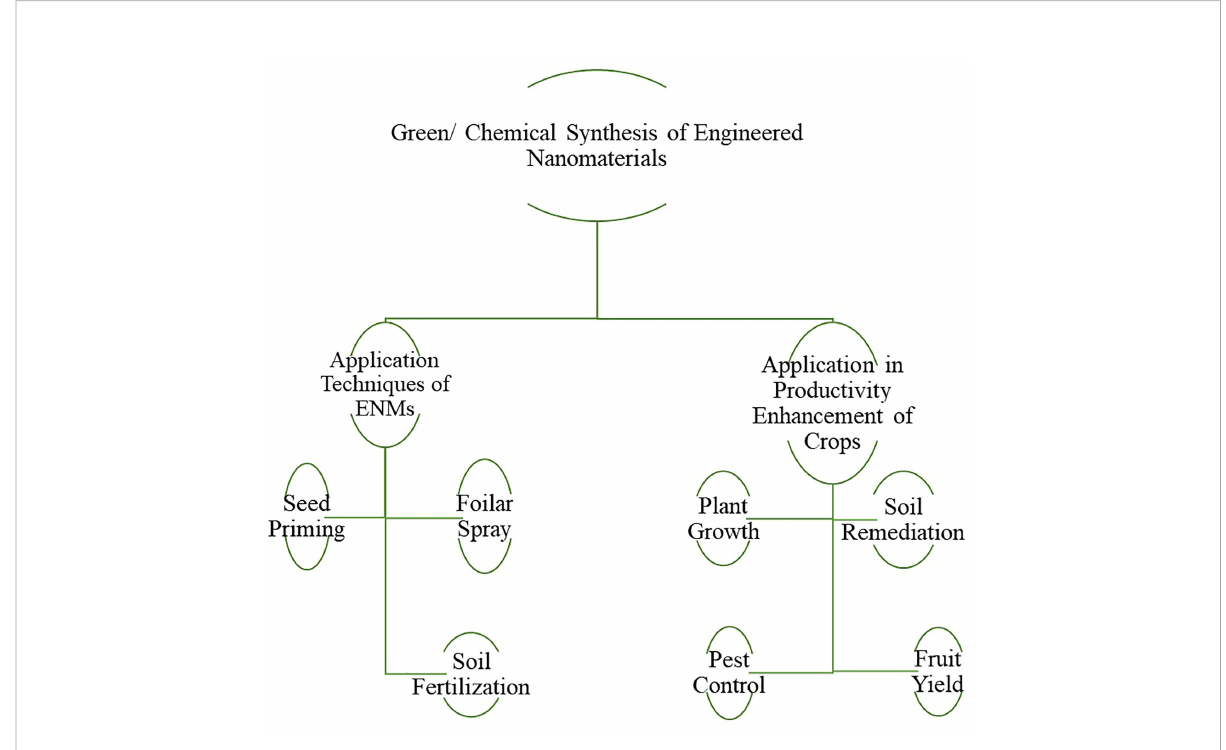
FIGURE 6 Application of engineered nanomaterials in agricultural